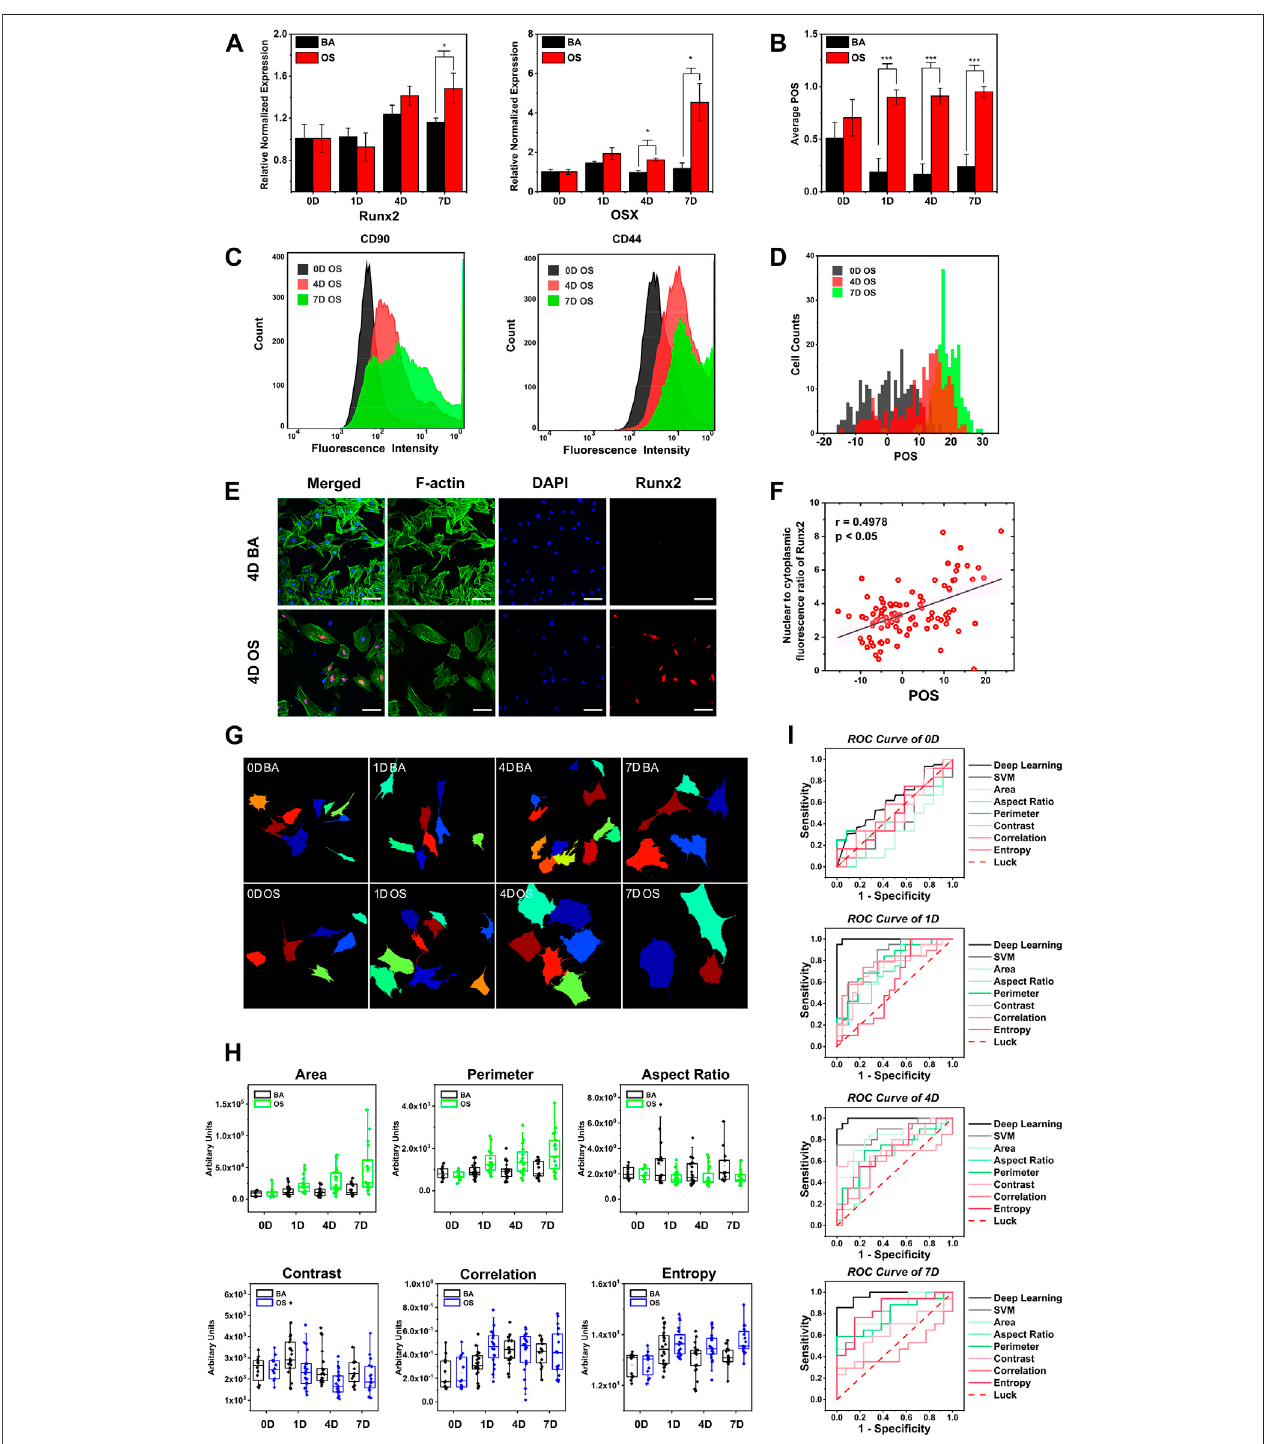
FIGURE 3 | OCNN highly correlated with conventional biochemical markers and performed better than single morphological parameter and support vector machineinosteogenicdifferentiationprediction. (A) Real-timePCRgeneexpressionlevelsof Osx , Runx2 relativeto GAPDH inrBMSCsculturedinBA/OSfor0,1,4,and 7 days (B) BA/OS Imagesof0, 1,4, and 7 days were classi fi ed and scored according toOCNN. (C) Flow cytometry determination ofthe MSC-speci fi c surfacemarkers (CD44, CD90) in OS groups at different induction times (0, 4, 7 days). (D) Images in the OS group of 0, 4, and 7 days were classi fi ed and scored according to OCNN. (E) rBMSCs ’ immuno fl uorescence staining of Runx2 protein cultured in both types of the medium on day 4. Green: F-actin; Blue: Nuclei; Red: Runx2 protein. Scalebar:100 µm. (F) UsingtheNuclear/cytoplasmintensityratioofRunx2proteintode fi netheextentofsingle-cellosteogenicdifferentiationandcomparedwithOCNN